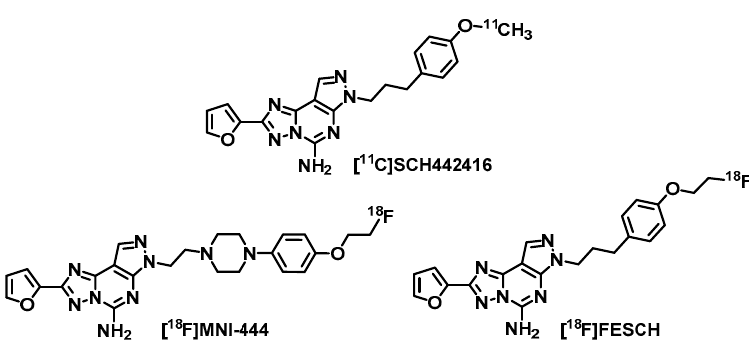
Figure 1. Molecular structures of the herein discussed radiotracers for positron emission tomography (PET) imaging of the adenosine A 2A receptor (A 2A R).